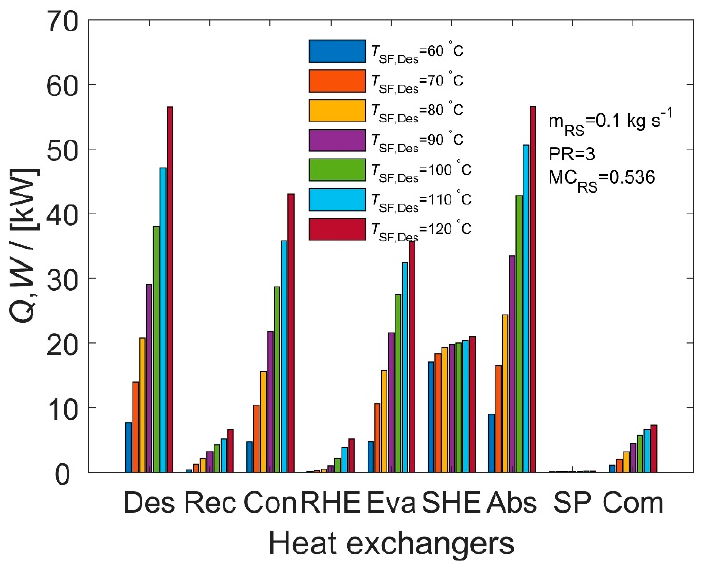
Figure 11. Heat exchanger loads and power consumption as functions of heat source temperature for the pressure ratio of 3.